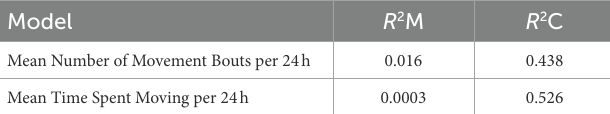
TABLE 5 Marginal and conditional R 2 for individual ACT derived annual movement LME models.